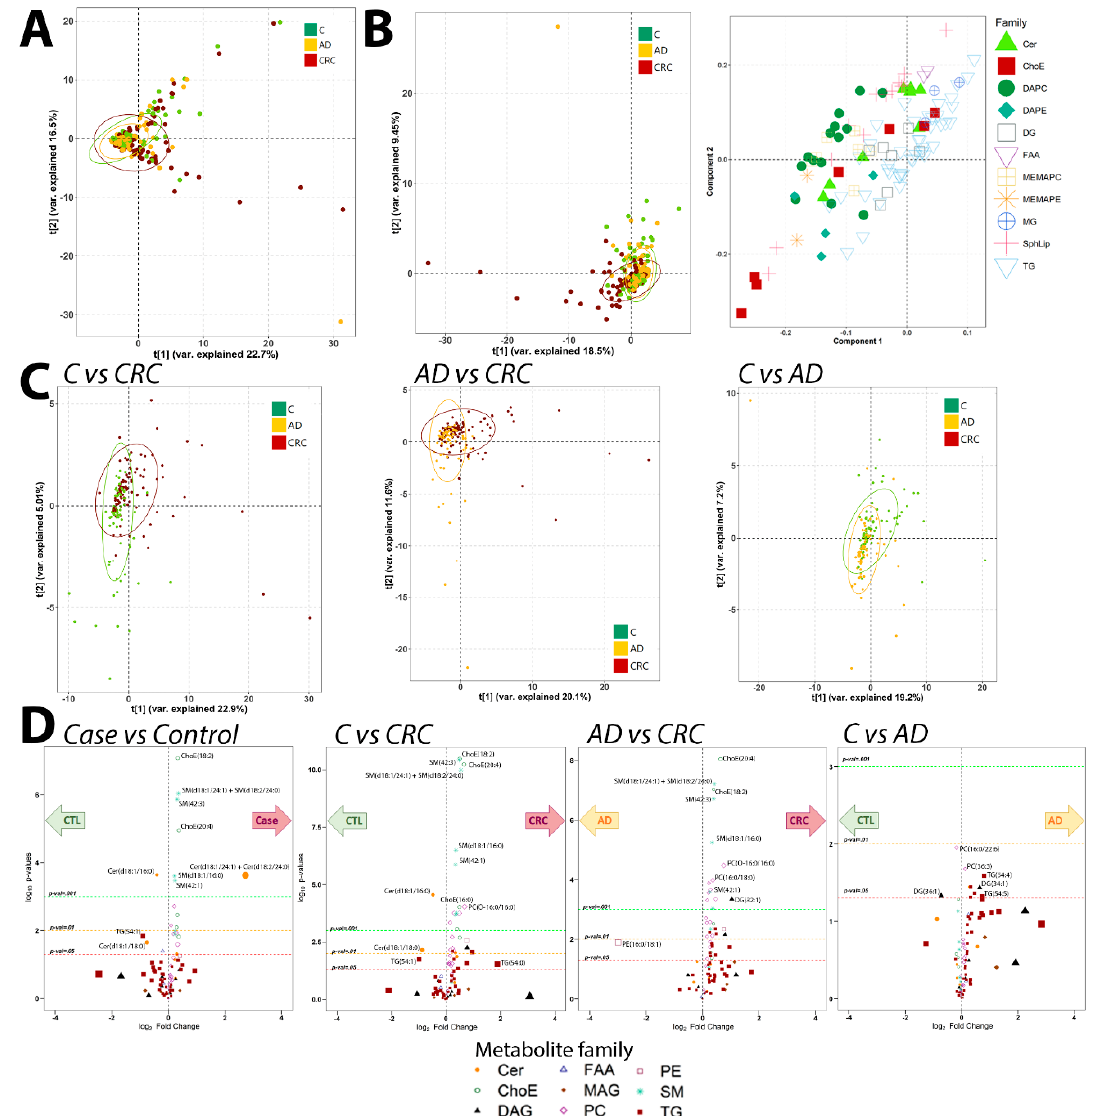
Figure 2. Multivariate and univariate analyses of the metabolomics data. Points are colored depending on their clinical classification. PCA scores plot ( A ), PLS-DA scores and loadings plot, with point shape and color depending on the metabolite class ( B ) and pairwise PLS-DA scores plots, from left to right: C vs. CRC, AD vs. CRC and C vs. AD comparisons ( C ). Volcano plots for the distinct comparisons of sample groups, with points shape and color depending on the metabolite class ( D ).